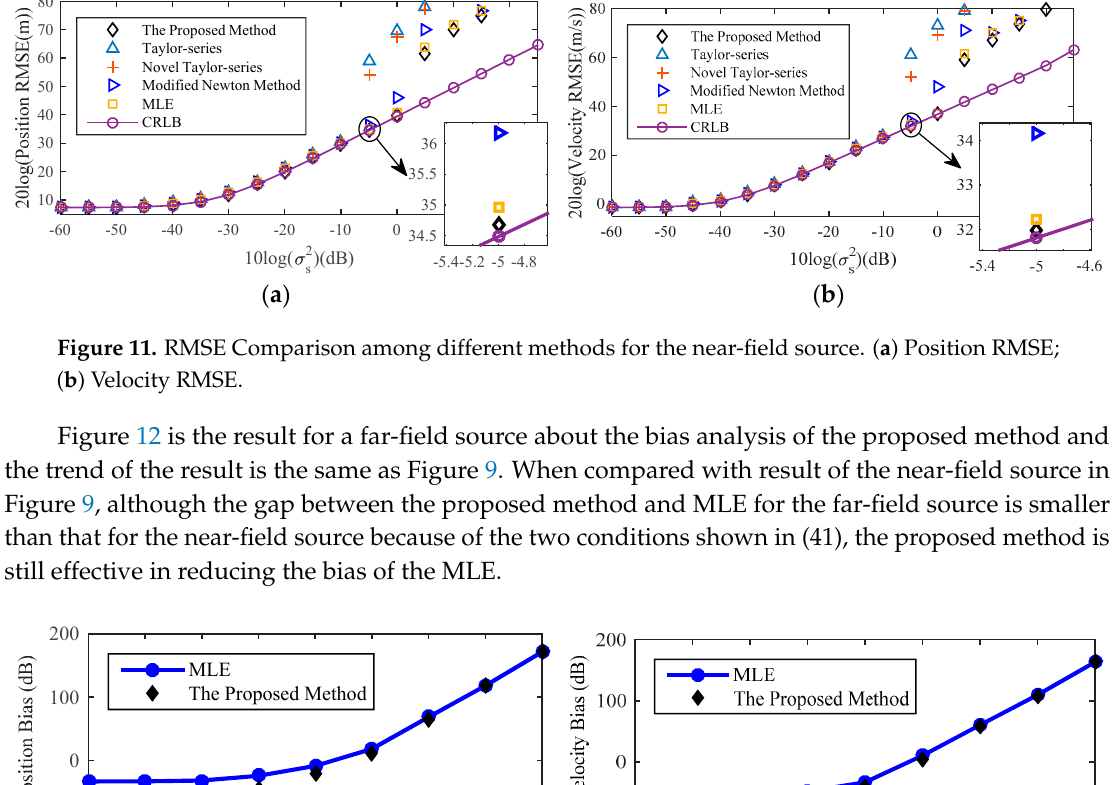
Position Bias; ( b ) Velocity Bias.